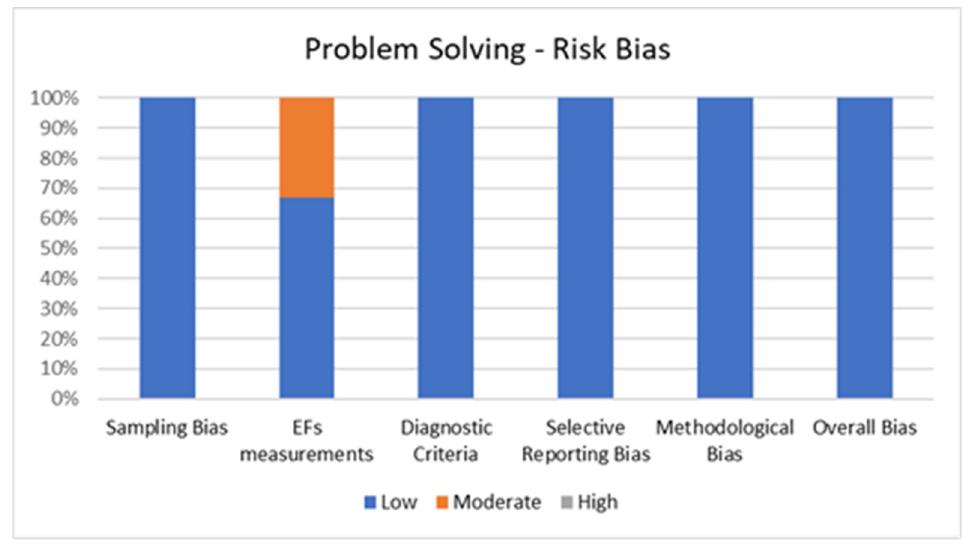
Figure 5. Risk of Bias for Problem Solving.